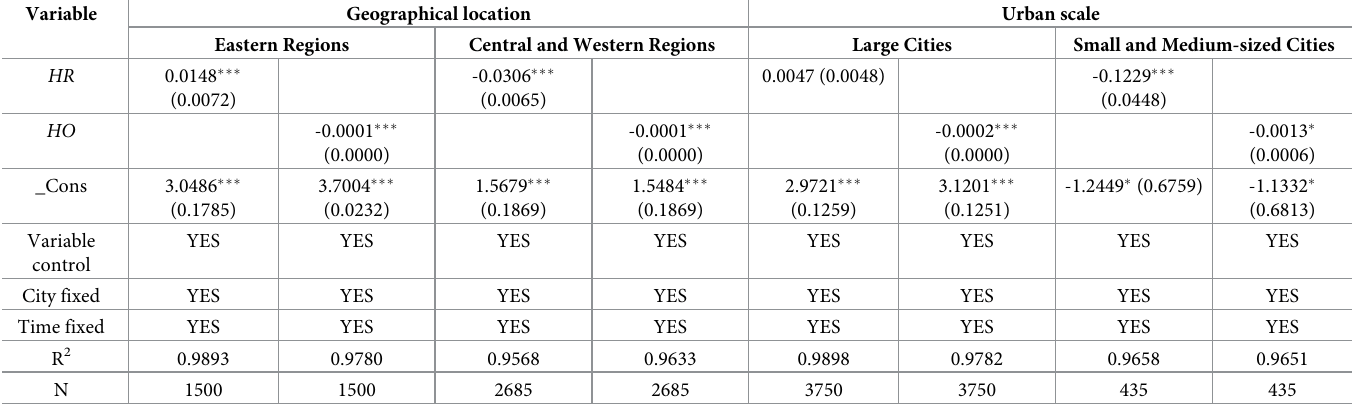
Table 3. Results of heterogeneity